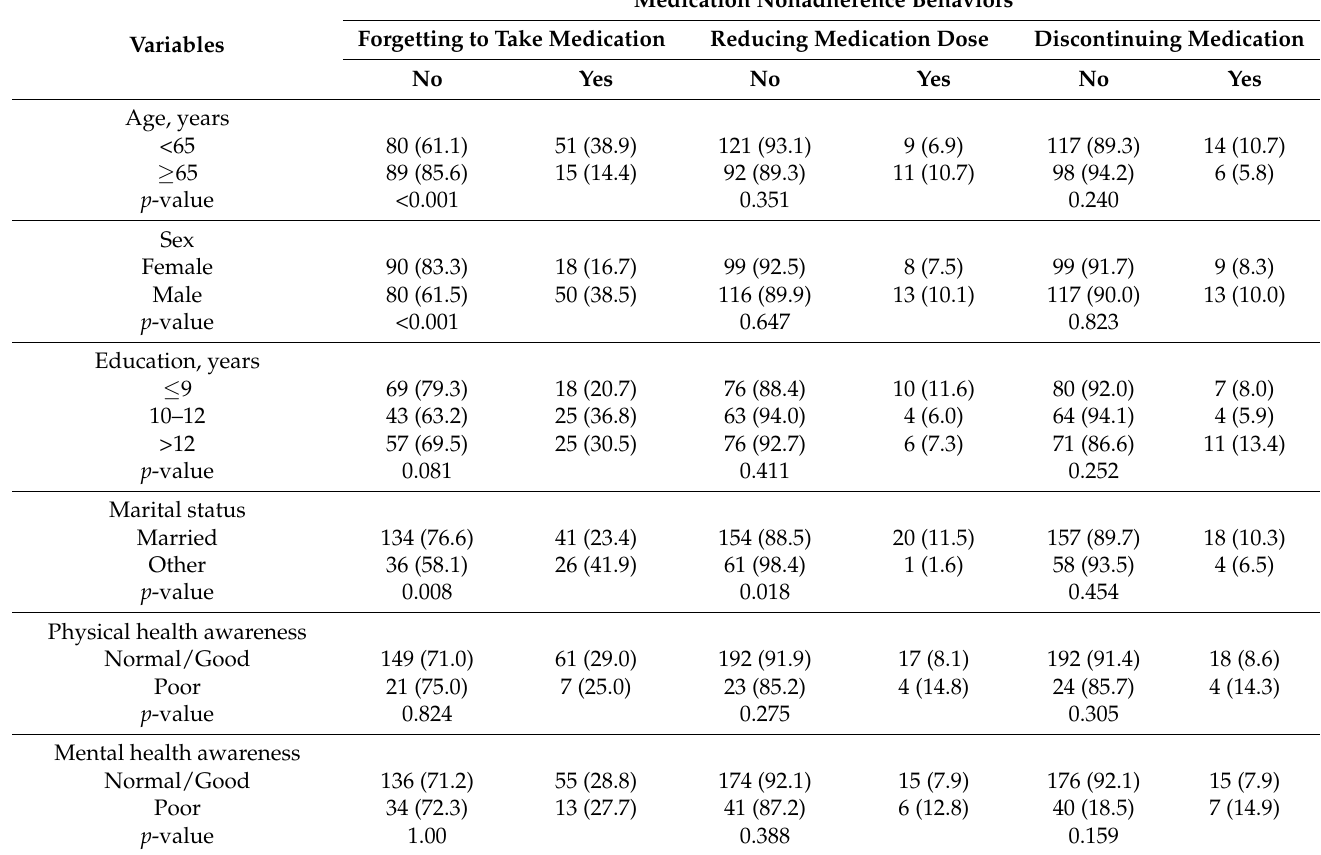
Table 2. Distribution of behaviors of nonadherence to medication according to demographic variables, lifestyle habits, sleep condition, physical/mental health awareness, and medication